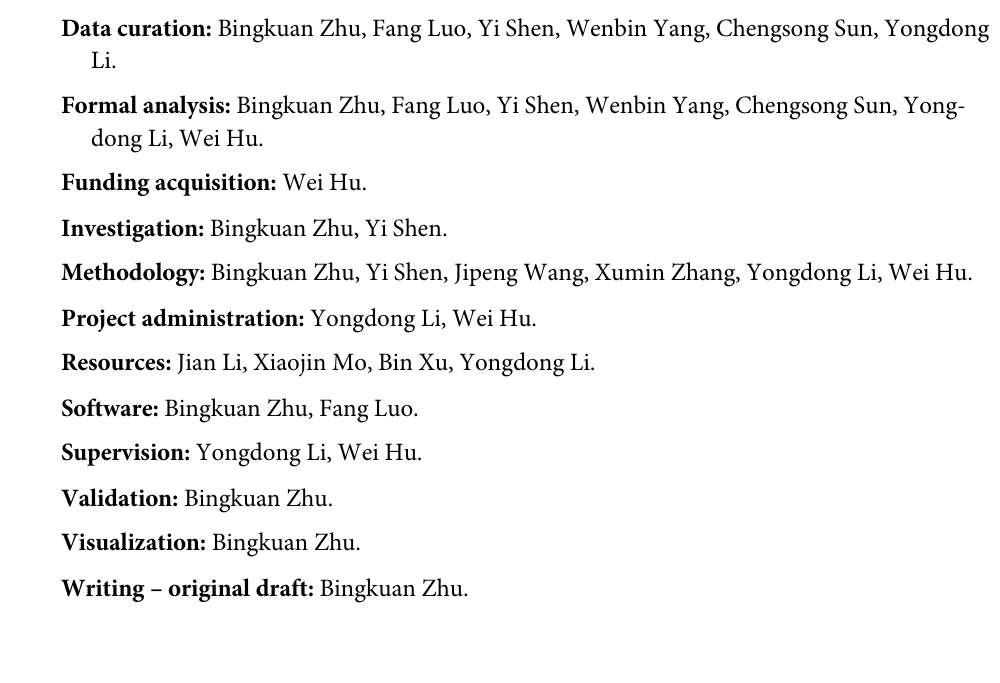
S2 Fig. Expression and purification of recombinant SjCB2 in E . coli . Lane 1: soluble fraction from E . coli cell lysates; Lane 2–3: column flow through; Lanes 4–8, 50 mM imidazole eluent; Lanes 9–12, 250 mM imidazole eluent; M, PageRuler Prestained Protein Ladder (Thermo Fisher Scientific). Arrowhead indicates rSjCB2. S3 Fig. SjCB2 was identified in the 42 dpi worms’ ES products. ES proteins of 42 dpi adult worms were resolved by SDS-PAGE, blotted onto PVDF membrane, and detected by pre- immune rabbit IgG (A) or anti-rSjCB2 IgG (B). S1 Table. Determination the titer of rabbit polyclonal antiserum against rSjCB2 by indi- rect ELISA. S2 Table. Determination of GST IgG titer in anti-rSjCB2 IgG after treatment by indirect ELISA.